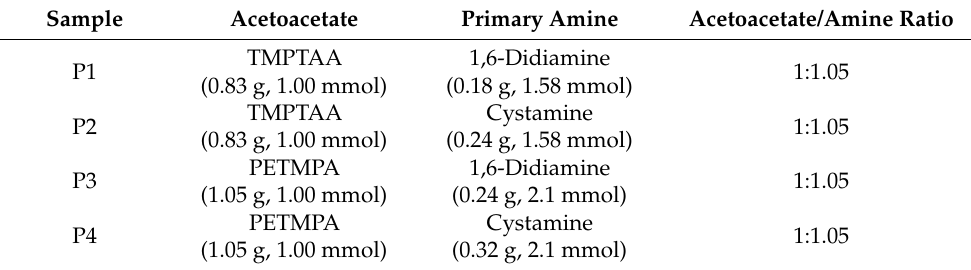
Table 1. Materials for the polymer film